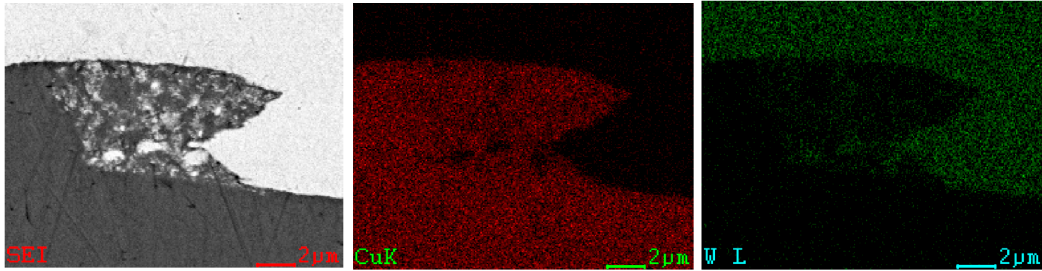
Figure 11. EDS-derived elemental maps for Cu and W of the W/Cu interface of T-6.